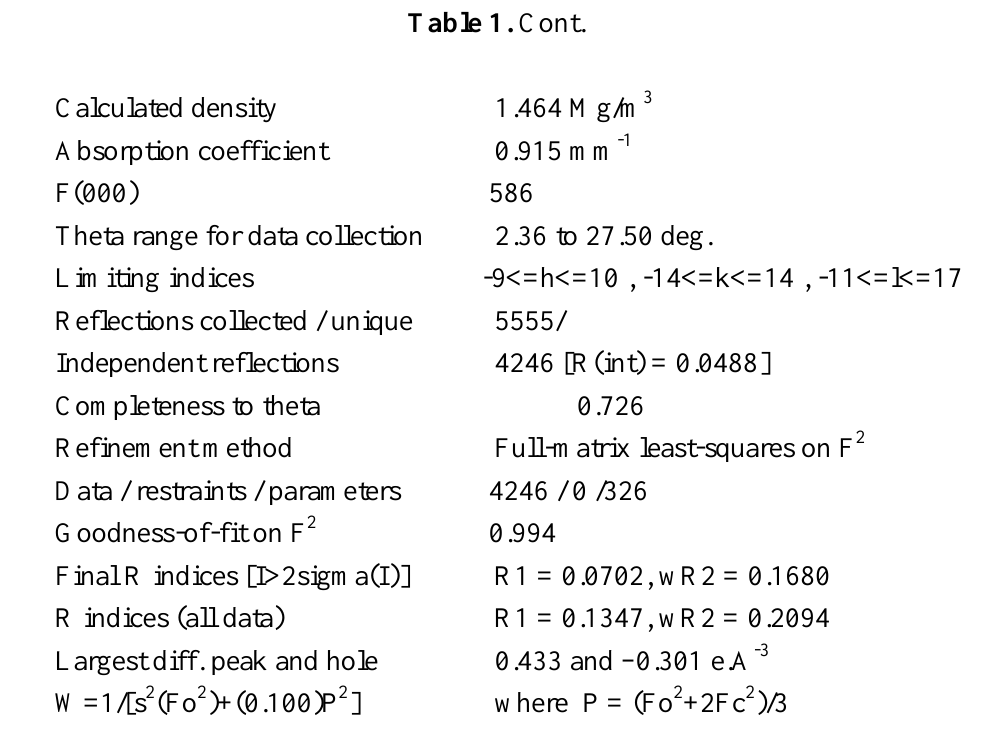
Figure 1: Molecular structure of CuLL